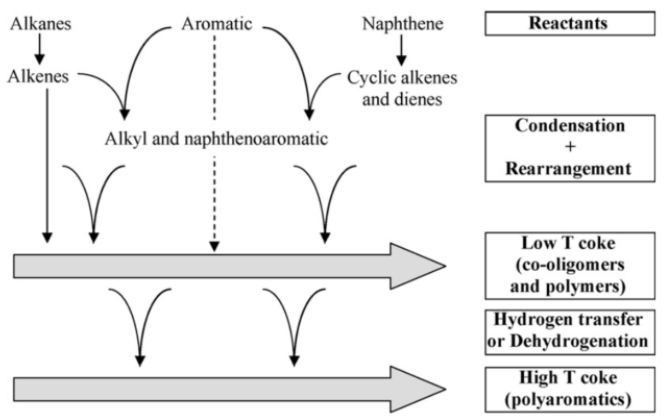
Figure 9. Simplified scheme of coke formation from hydrocarbons and molecular coke over acid zeolite catalysts. Guisnet et al. [75].